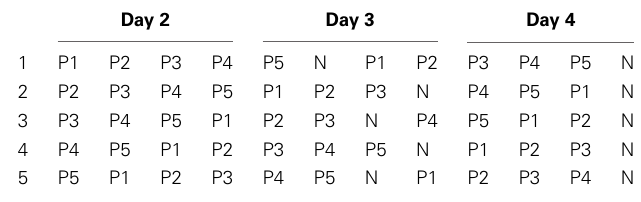
Table 1 | Testing orders for days